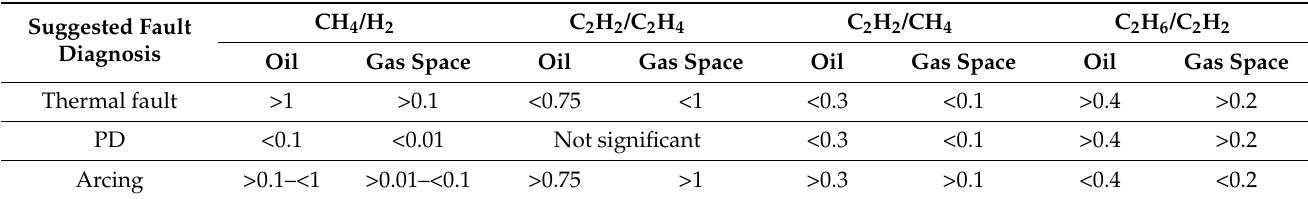
Table 2. Doernenburg-C ratio method.